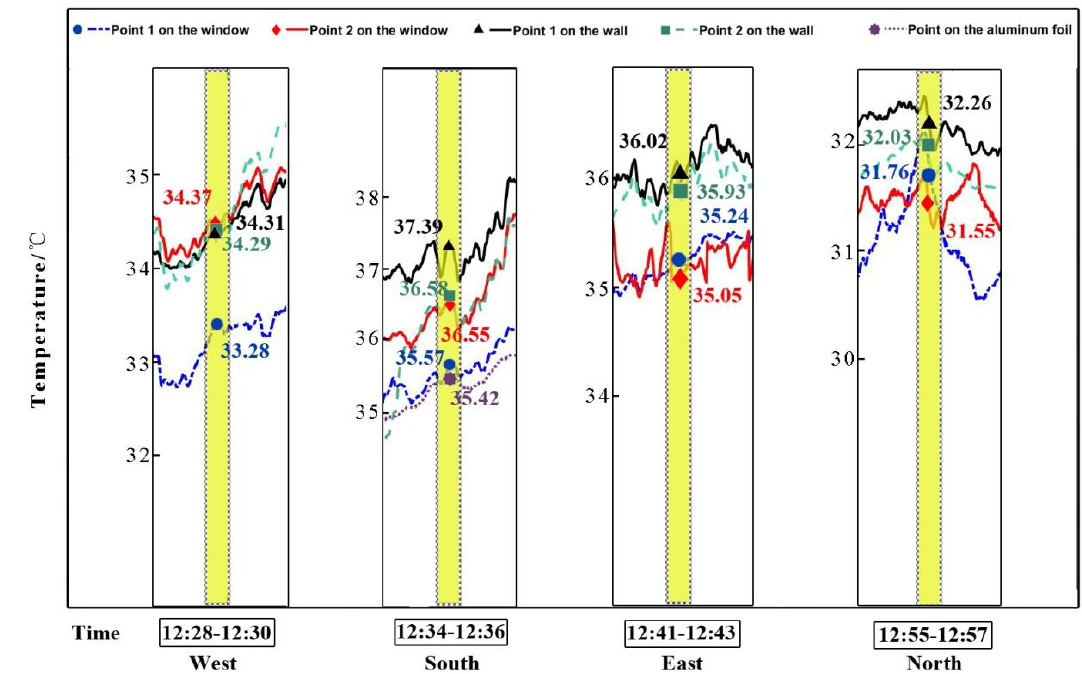
Figure 15. The temperature value of the wall surface measured by thermocouple.